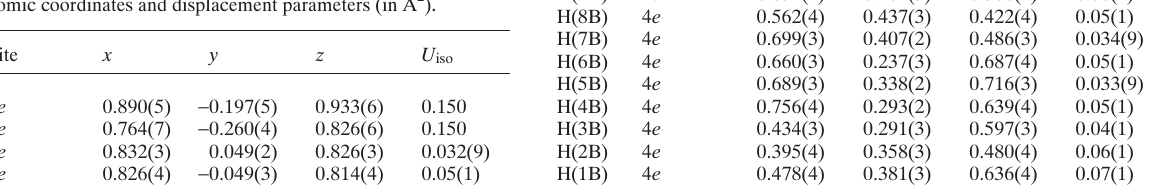
Table 2. Atomic coordinates and displacement parameters (in Å 2 ) .